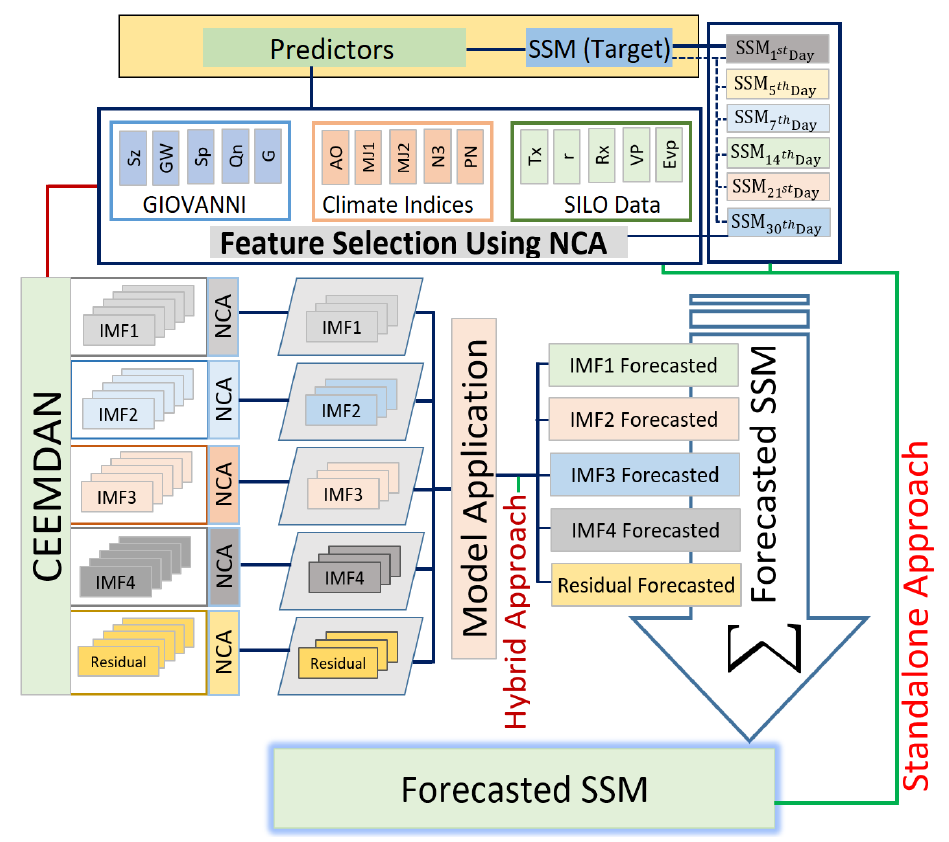
Figure 3. Workflow with the steps in model design for hybrid CEEMDAN-CNN-GRU predictive model. SSM = Surface Soil Moisture, NCA = neighbourhood component analysis for regression, IMF = Intrinsic Mode Function, CEEMDAN = Complete Ensemble Empirical Model Decomposition with adaptive noise, GRU = Gated Recurrent Units.